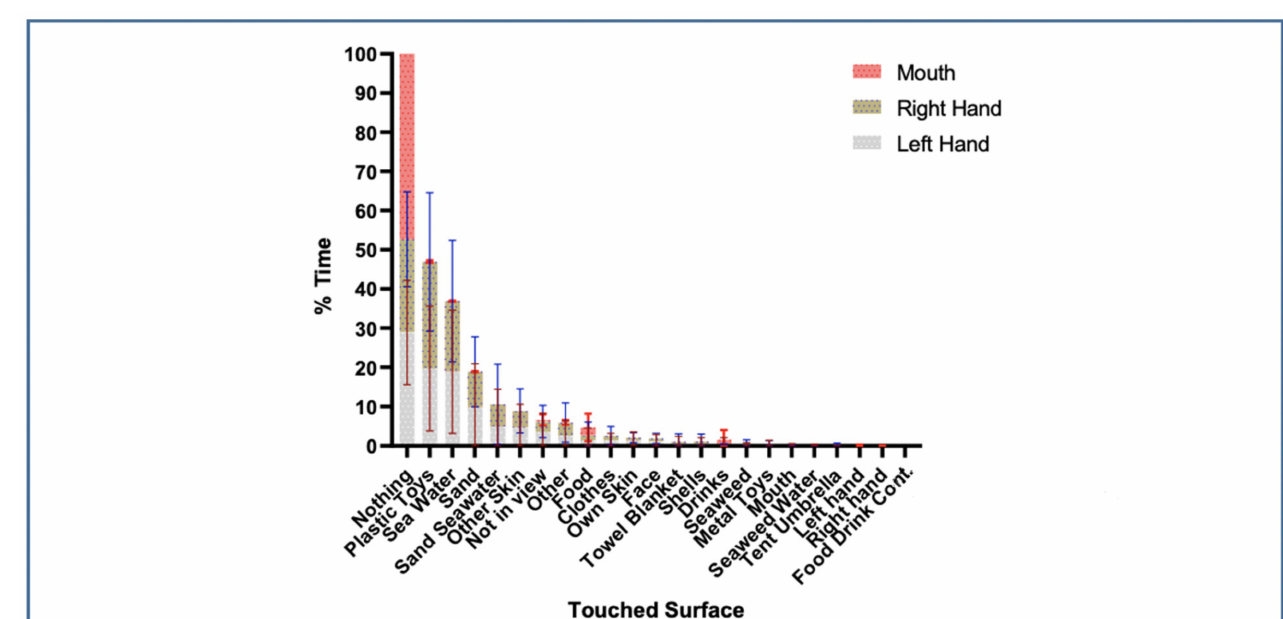
Figure 5. Mean Percent Time Right-Hand, Left-Hand, and Mouth Contact